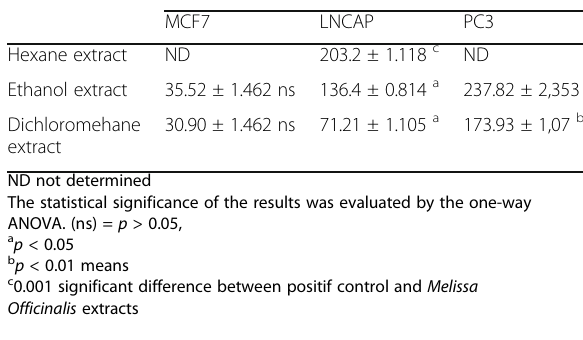
Table 6 IC 50 values of Melissa officinalis extracts in four MCF7, LNCAP, and PC3 cell lines